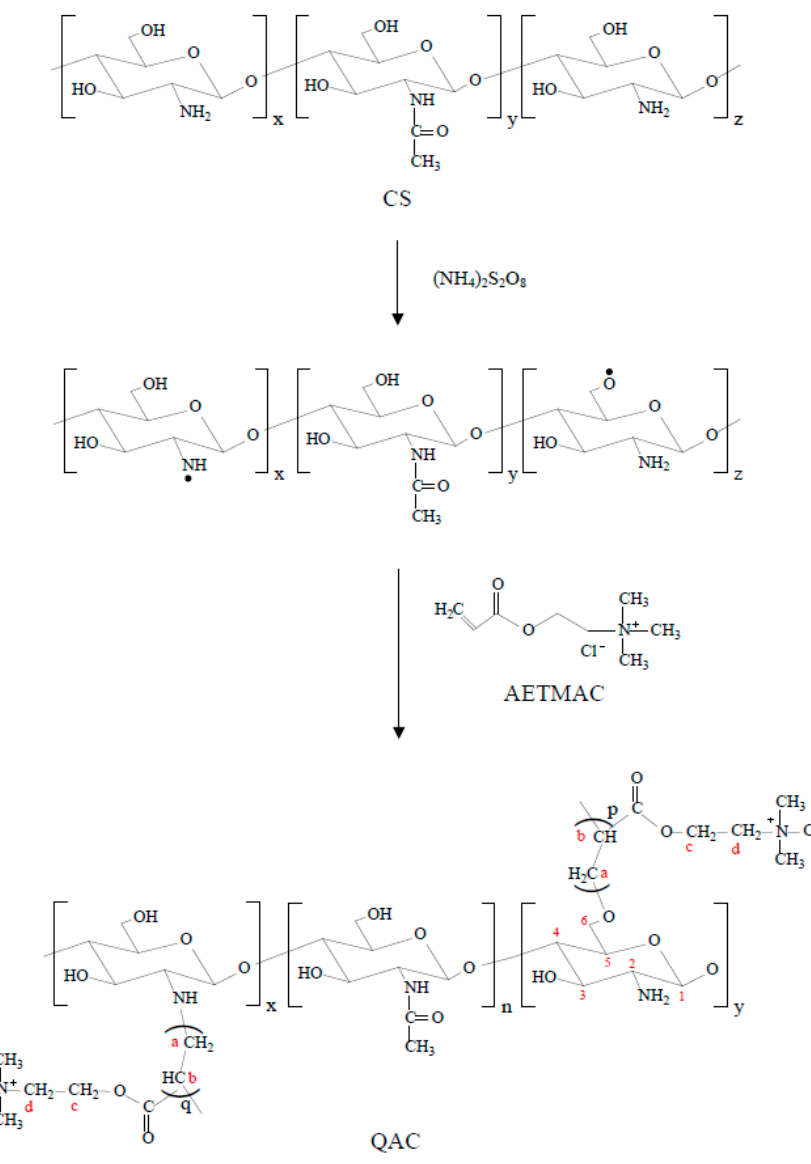
Figure 1. Schematic representation of graft-copolymerization of AETMAC onto CS.